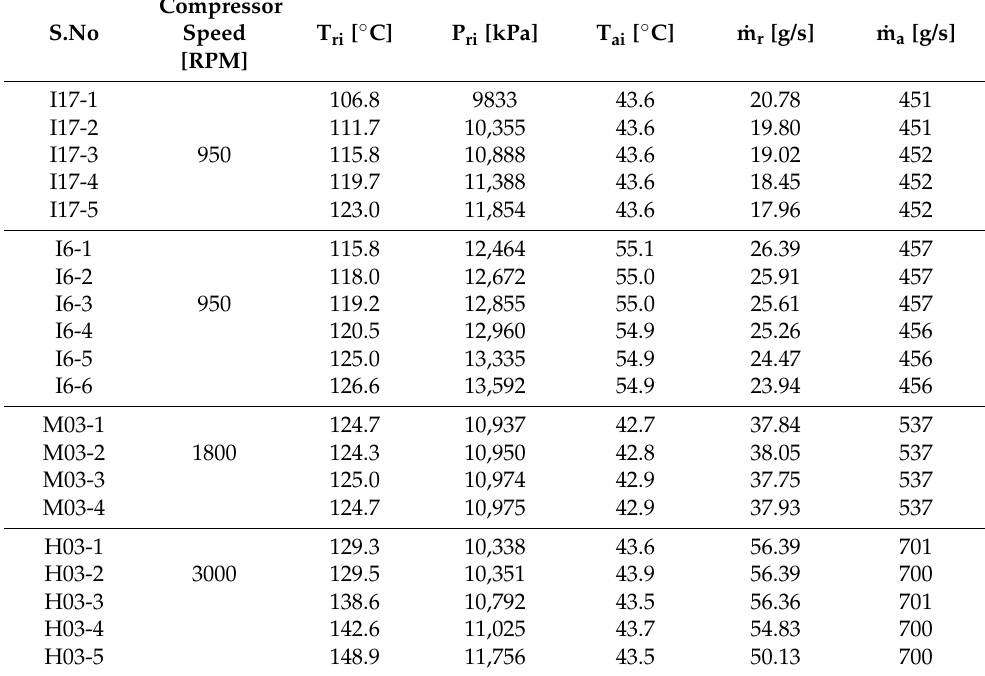
Table 2. Operating